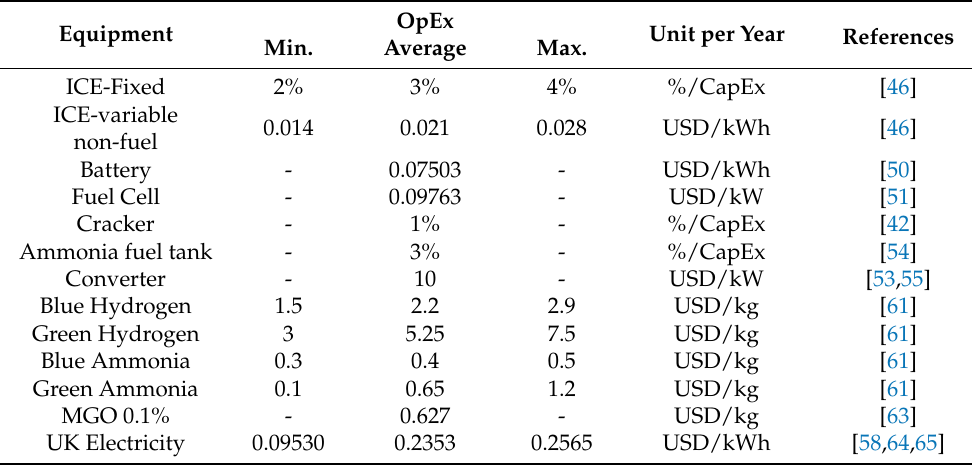
Table 6. List of operational expenditures.